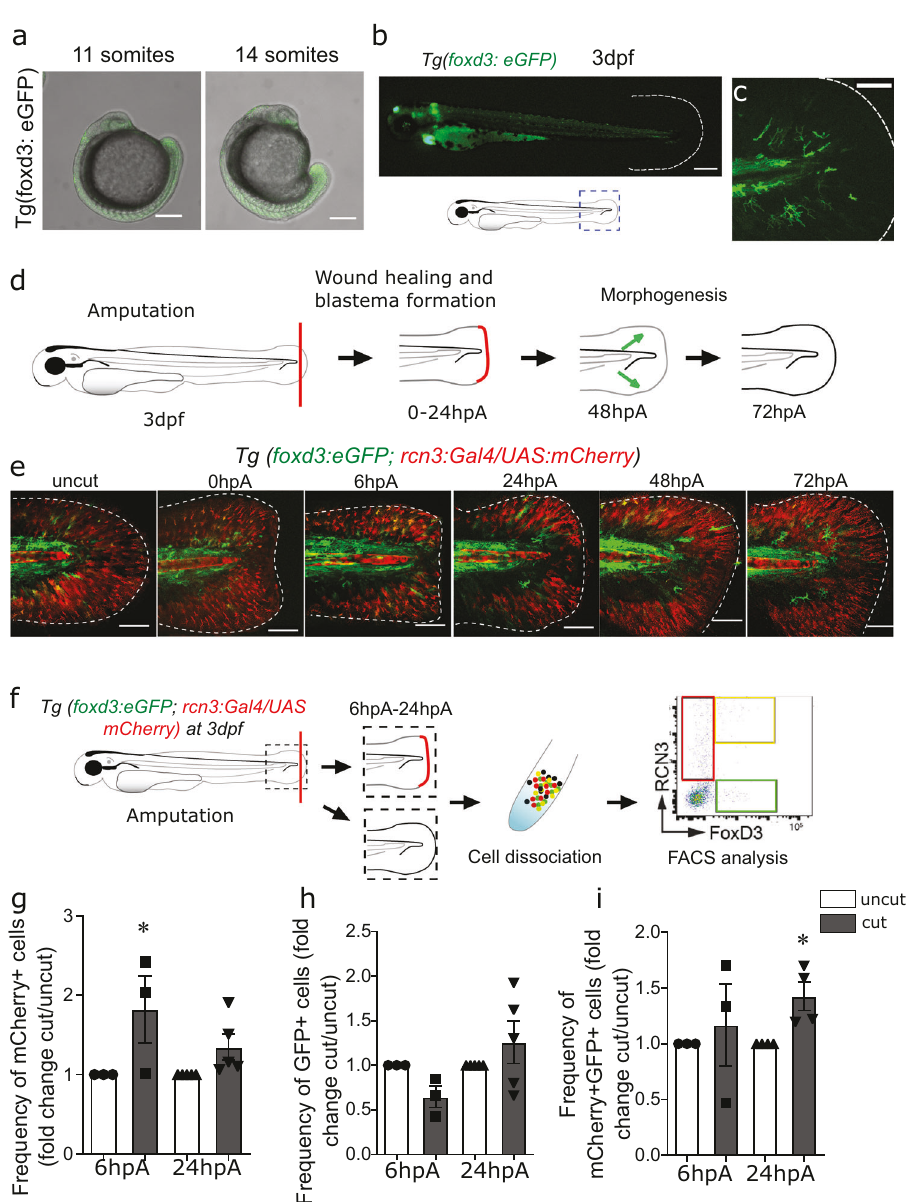
Fig. 2 Foxd3 + NCdC in the developing and regenerating caudal fi n fold mesenchyme are located next to proliferative rcn3 + mesenchymal cells. a Confocal images of Tg(foxd3:eGFP-F) zebra fi sh embryos at 11 somites and 14 somites (Scale bars = 300 µ m). b , c Representative fl uorescent images of Tg(foxd3:eGFP-F) 3 dpf larvae (Scale bar = 400 µ m. ( b ) scale bar = 80 µ m ( c ) d Schematic representation of caudal fi n fold regeneration after amputation of 3 dpf larvae. e Representative confocal microscopy images of Tg(foxd3:eGFP-F/rcn3:Gal4/UAS:mCherry) larvae during regeneration (Scale bars = 80 µ m, representative from 5 biologically independent larvae examined over 3 independent experiments). f Schematic representation of the fl uorescent-activated fl ow cytometry analysis of eGFP + and mCherry + cells from caudal fi n fold of Tg(foxd3:eGFP-F/rcn3:Gal4/UAS:mCherry) larvae at 6 and 24 hpA. Data were analysed using FlowJo v10. g Frequency of mCherry + cell number in the caudal fi n fold at 6 and 24 hpA relative to the age-matched uninjured controls. h Frequency of eGFP + cell number in the caudal fi n fold at 6 and 24 hpA relative to the age-matched uninjured controls (fold change). i Frequency of mCherry + eGFP + cell number in the caudal fi n fold at 6 and 24 hpA relative to the age-matched uninjured controls. g – i Graphs represent the mean value ± SEM, one-tailed Wilcoxon test was performed, * p < 0.05, p = 0.05 ( g ), p = 0,0143 ( i ), n = 50 – 300 larvae per group from 5 independent zebra fi sh larvae revealed that cell proliferation rate was sig- proliferation, we used homozygous Tg(foxd3:mCherry) ct110 3 dpf ni fi cantly lower in regenerating foxd3 morphants (MO foxd3 ) larvae that present similar defects in NC cell development as compared with controls (MO ctl ) (Fig. 3d) and consequently foxd3 morphants 30 . Compared with control zebra fi sh larvae (wild type, WT), fi n fold outgrowth was severely impaired in caudal fi n fold growth was signi fi cantly reduced, compared with Tg(foxd3:mCherry) ct110 mutant larvae at 72 hpA (Fig. 3h). This embryos injected with control morpholino (MO ctl ) (Fig. 3e). This impairment of the regenerative capacity was associated with a was correlated with the altered expression pattern of junbl , a signi fi cant decrease of PH3 + cells in the blastema compared with blastemal marker 31 , observed by in situ hybridization (Supple- mentary Fig. 3f). To con fi rm NCdC role in blastemal cell WT zebra fi sh (Fig. 3g), as well as a decrease of junbl expression at